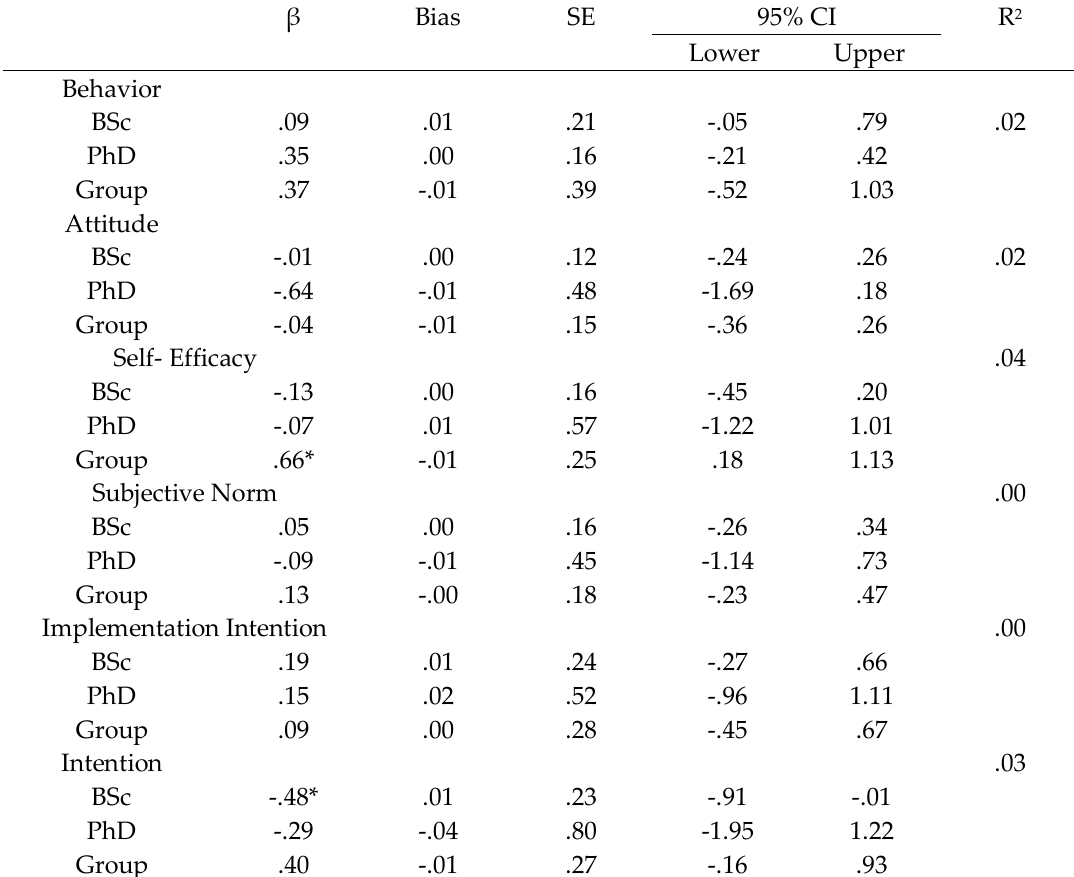
Table 4 . Multiple Linear Regression Results for Major Outcome Variables by Education Level and Group with Bias Corrected Bootstrapping Confidence